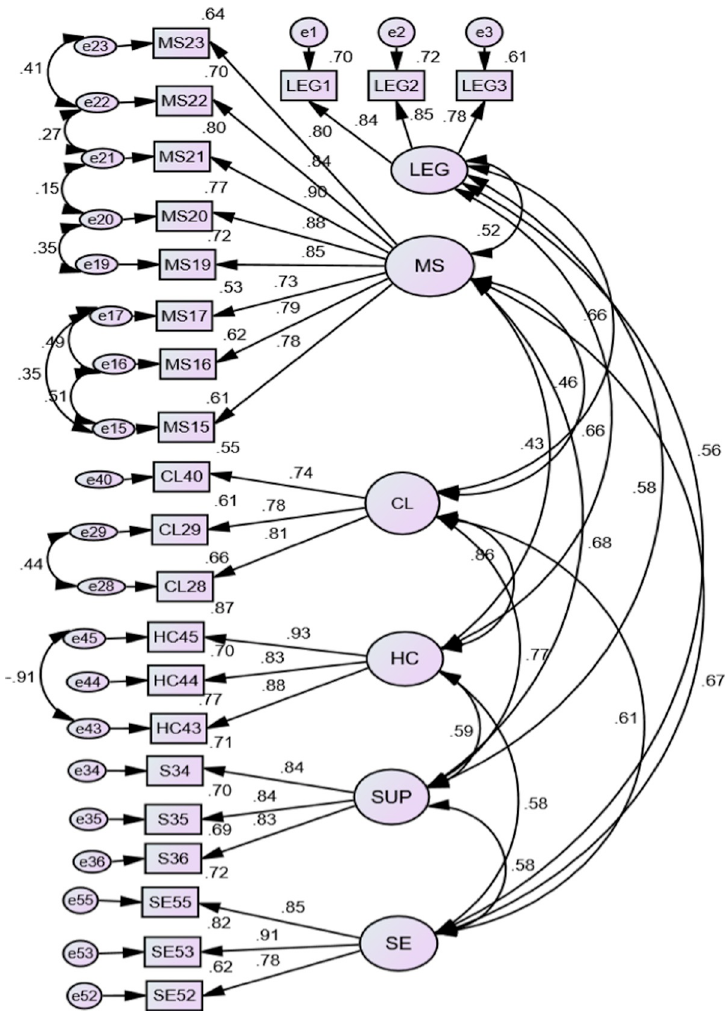
Fig 2. SEM CSRSMEs model. Notes: Chi-square=4222.794; Probability level=0.000; Degrees of freedom=215; Chi- square normed=1.966. RMSEA = 0.068 LO 90=0.58 p=0.001; CFI=0.948; PCFI=0.806; NFI=0.901; PNFI=0.766; TLI=0.939. Source: Own